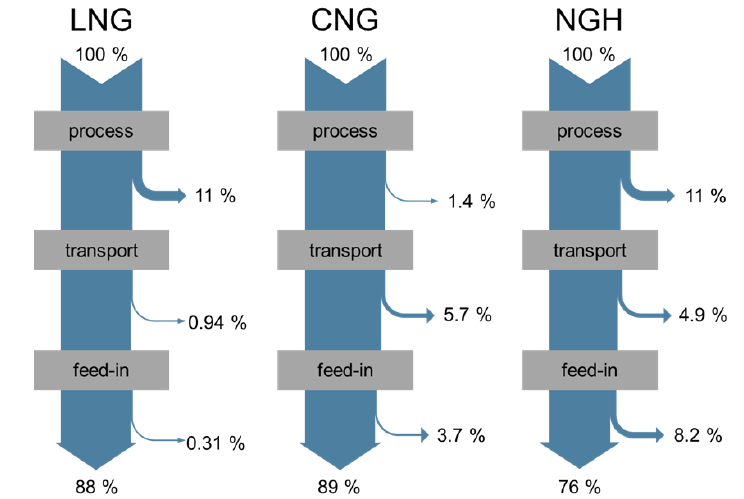
Figure 9. Energy flow diagrams for the transport options LNG, CNG and methane hydrate (20,000 Nm 3 ·h − 1 /1000 km scenario)